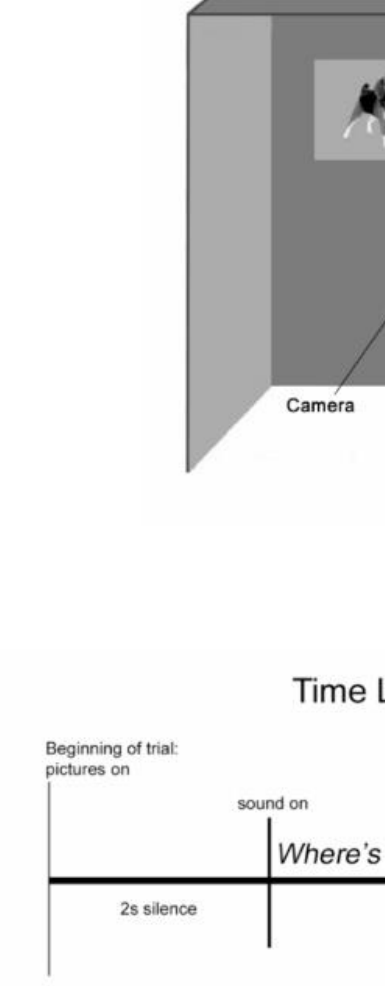
Figure 6. Configuration of test booth with rear-projection screen used in the looking-while-listening procedure ( A ). Schematic timeline for a typical trial ( B ) reprinted with permission from [62]. Copy- right 2008 Benjamins.